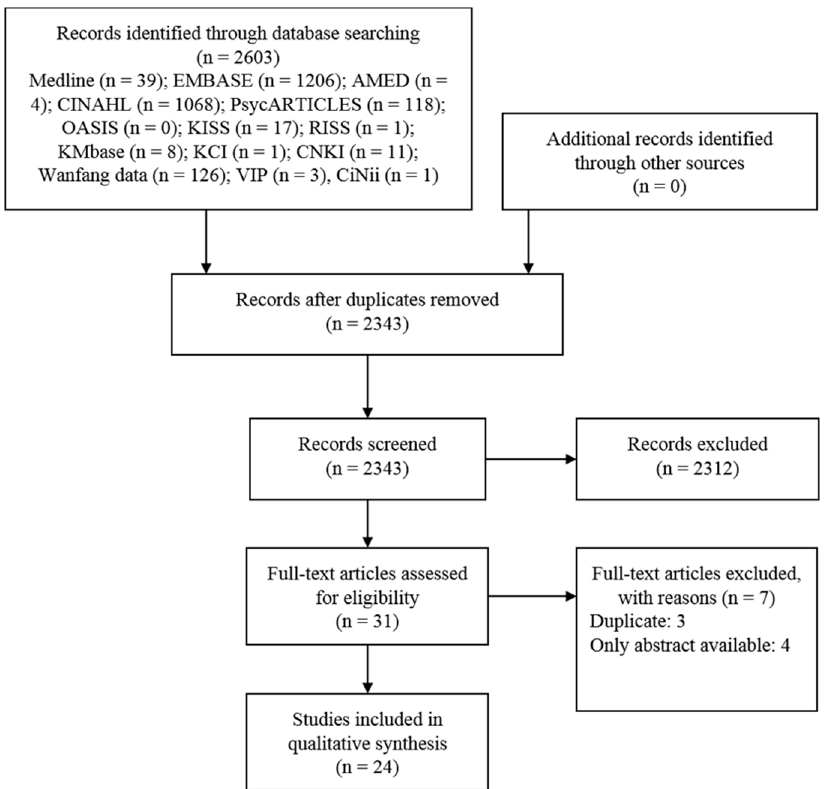
Figure 1. A PRISMA flow diagram of the literature screening and selection processes. AMED, Allied and Complementary Medicine Database; CINAHL, Cumulative Index to Nursing and Allied Health Literature; CNKI, China National Knowledge Infrastructure; KCI, Korea Citation Index; KISS, Korean Studies Information Service System; KMbase, Korean Medical Database; OASIS, Oriental Medicine Advanced Searching Integrated System; RISS, Research Information Service System.